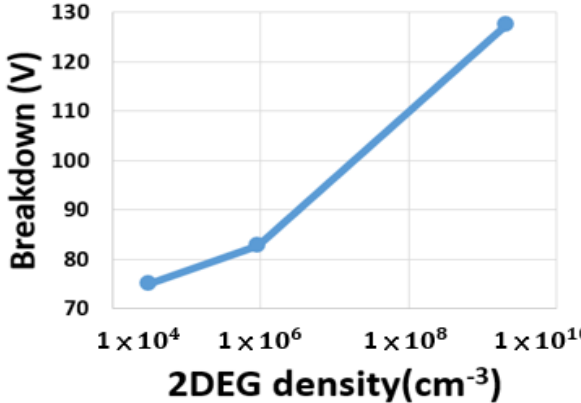
Figure 10. Breakdown vs. 2DEG density.